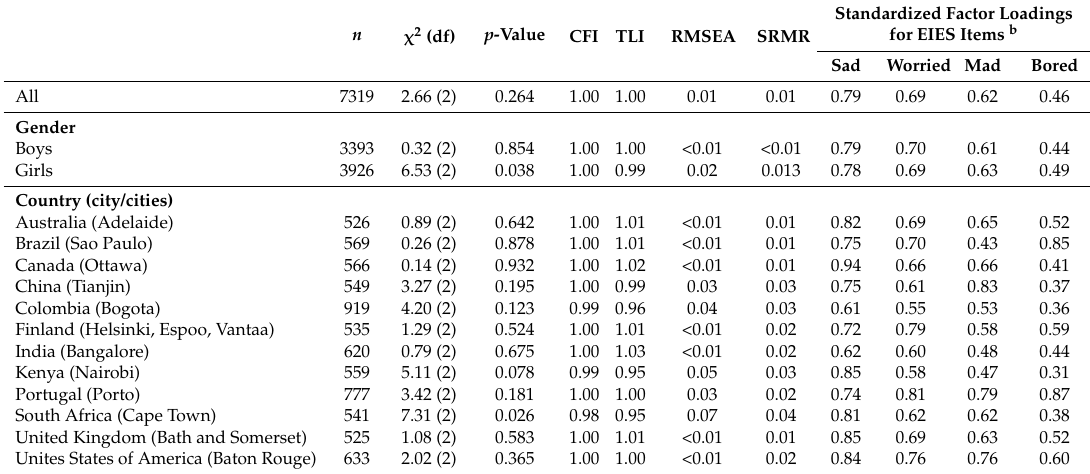
Table 1. Confirmatory factor analysis a for Emotion-Induced Eating Scale (EIES) negative emotion items. n χ 2 (df) p -Value CFI